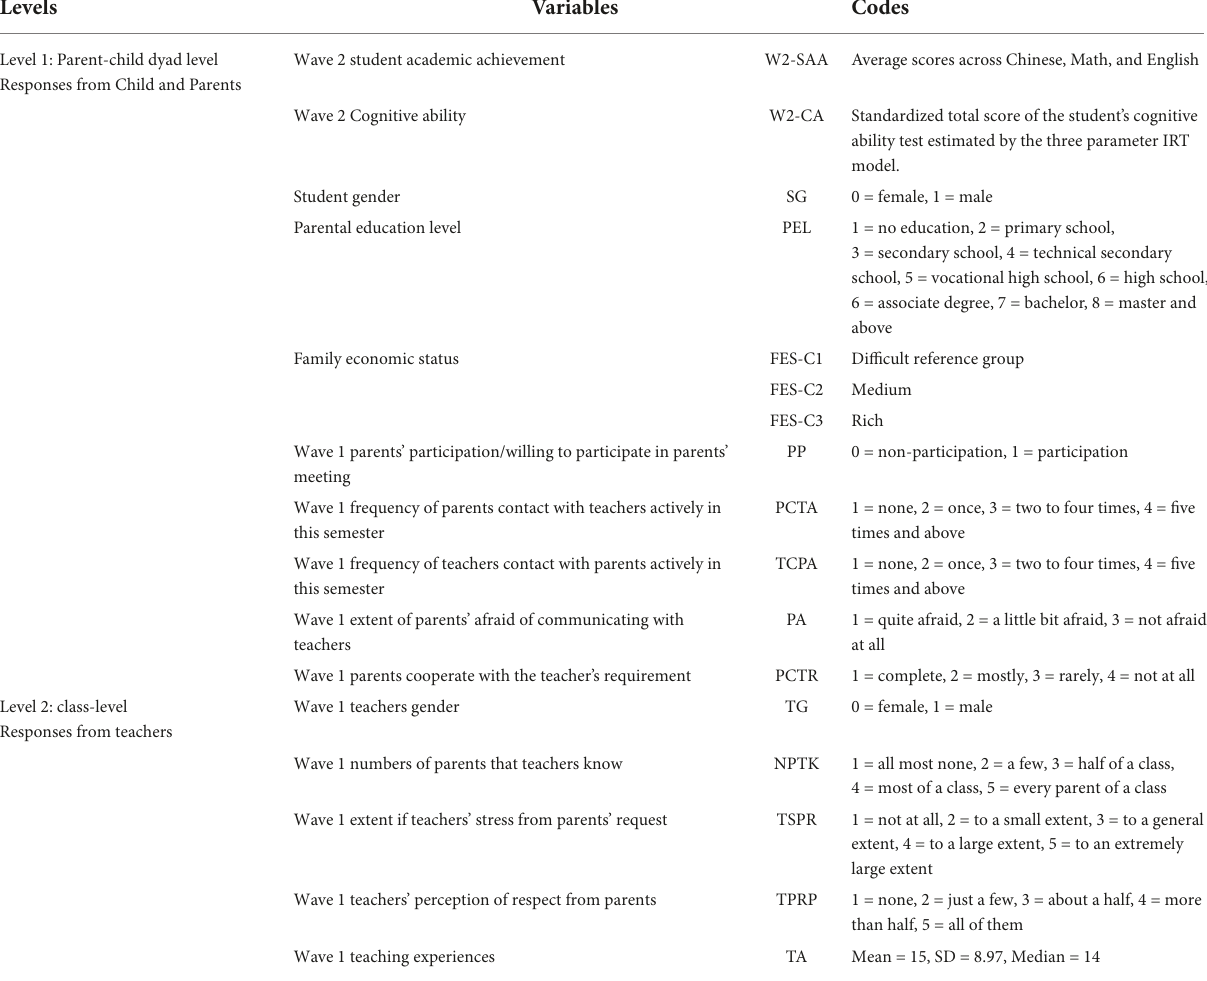
TABLE 1 Research